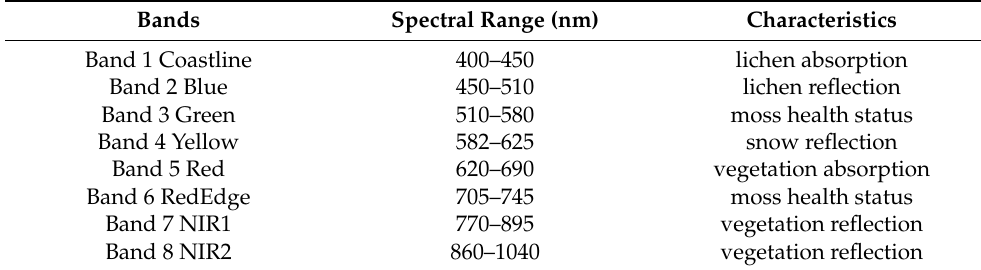
Table 1. Description of WV-2 multispectral bands.